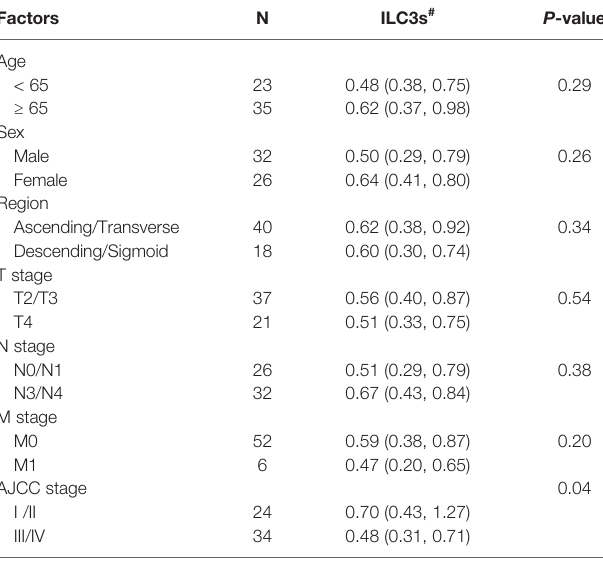
TABLE 1 | Correlations between tumor in fi ltrating ILC3s and clinicopathological factors of colon cancer.